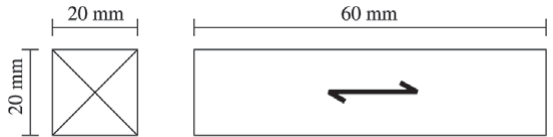
Figure 1. Dimensions of the test specimens.